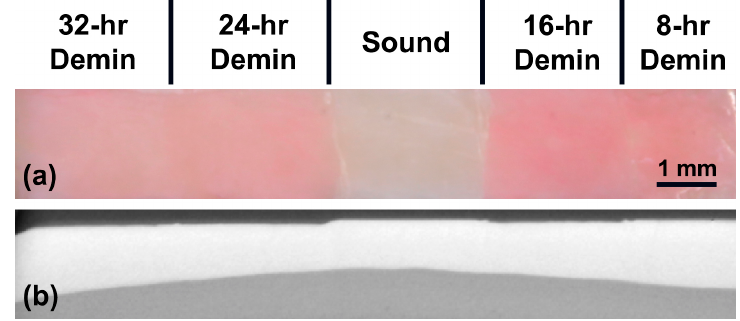
Figure 3. ( a ) Visible light reflectance image and ( b ) the corresponding µ CT section image. Table 1. Mean ± S.D. for lesion depth and ∆ Z from µ CT measurements. Groups with the same letters are statistically similar, p > 0.05 in each row (n =